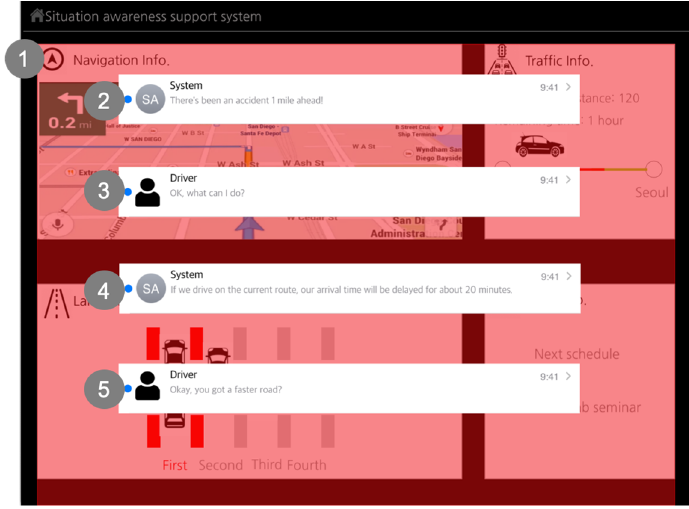
Figure 11. Descriptions of the interaction screen between the SA system and the participant (Source: Own creation): ( 1 ) It supports [Direct Perception]. The driver’s attention becomes arousal through proactively blinking red and green colors and it switches from driving to the situation information fast; and ( 2 ) it supports [Active Communication]. The driver can communicate actively with a system and it helps comprehension of the situation via voice interaction; ( 3 ) After the driver understands the situation, the driver can ask for more information which affects the projection; ( 4 ) Since the system tells the disadvantage of the current route, the driver can change the driving strategy; and ( 5 ) The driver checks the options to change the driving strategy.